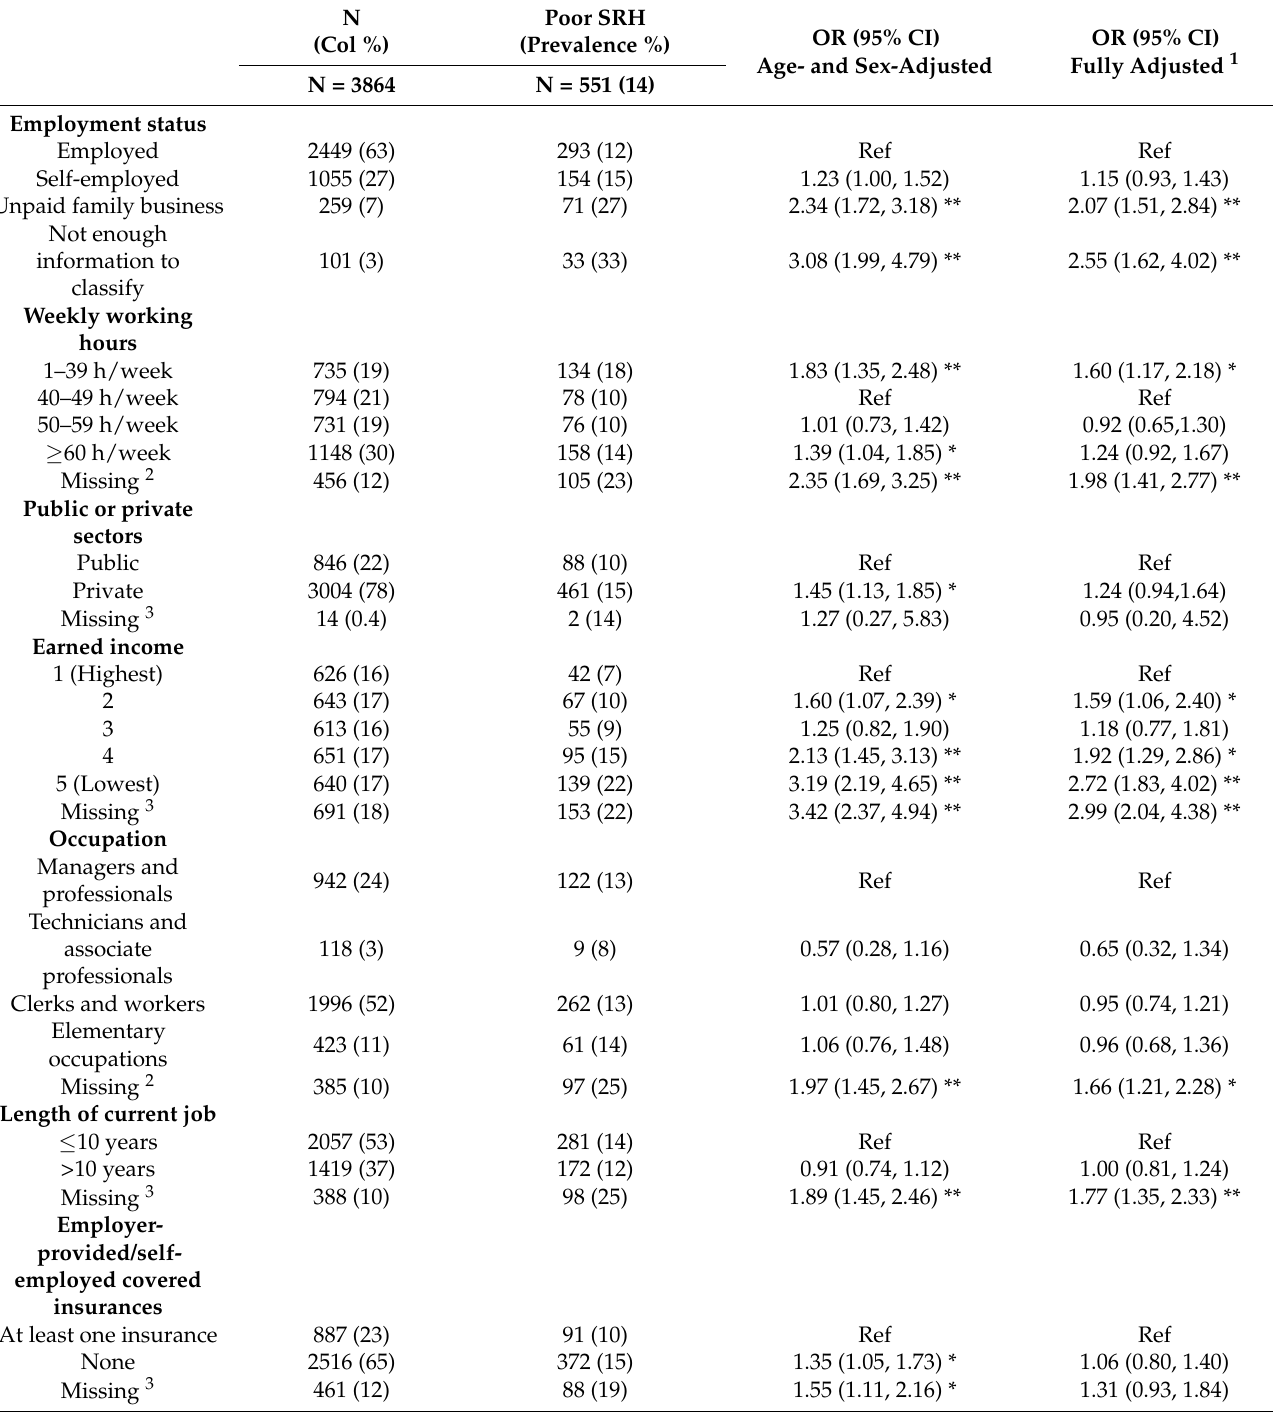
Table 2. Association between each labour-market characteristic and poor self-rated health in the Chinese working